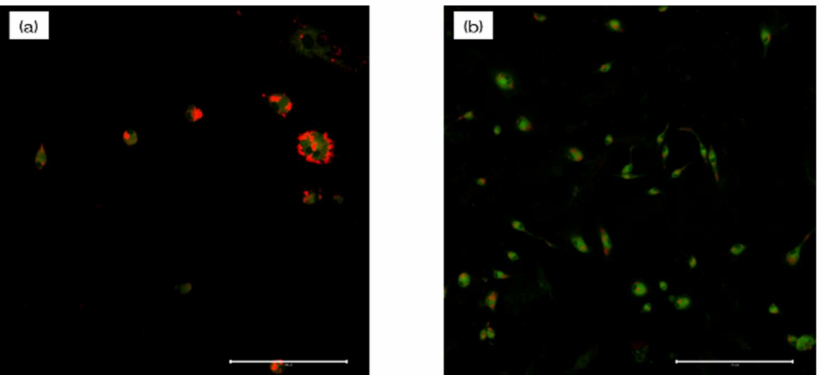
Figure 10. To measure mitochondrial function, mitochondrial membrane potential change was determined for the macrophages and was assessed by JC-1 staining. Fluorescence microscopy showed that in the test group, RBMCs displayed strong J-aggregation (red) and weak JC-1 monomer (green), while in the plate and Ti groups, RBMCs showed higher JC-1 monomer (green) levels with concomitantly decreased J-aggregation (red) due to low ∆Ψ m. This indicated that ∆Ψ m and oxidative stress on mitochondria were inhibited by UV-treated NANOZR. ( a ) untreated NANOZR; ( b ) UV-NANOZR. (scale bar: 200 µ